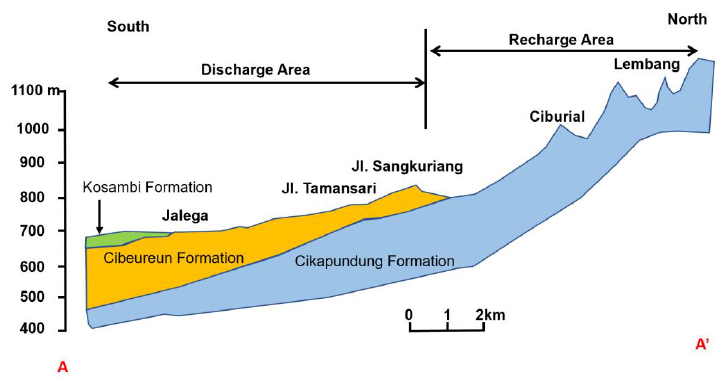
Figure 2. The aquifer profile A –A’ (in Figure 1) of Bandung